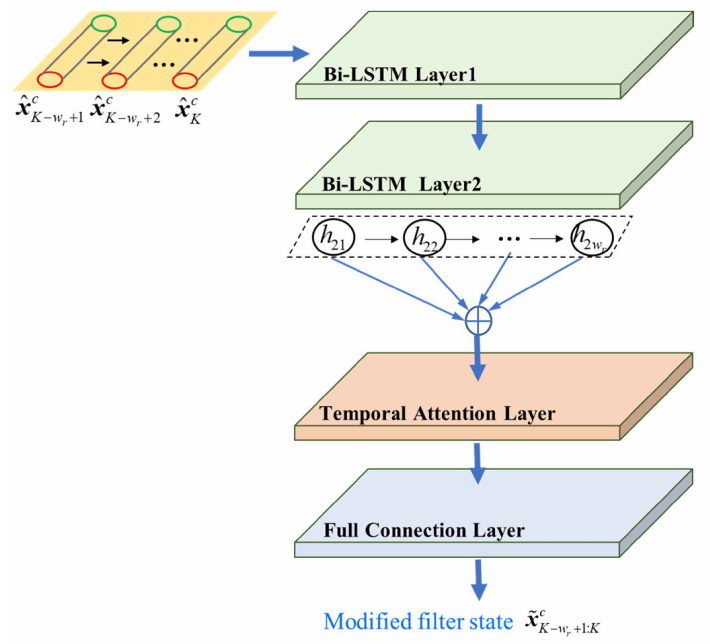
Figure 4. Structure of the filter state modification